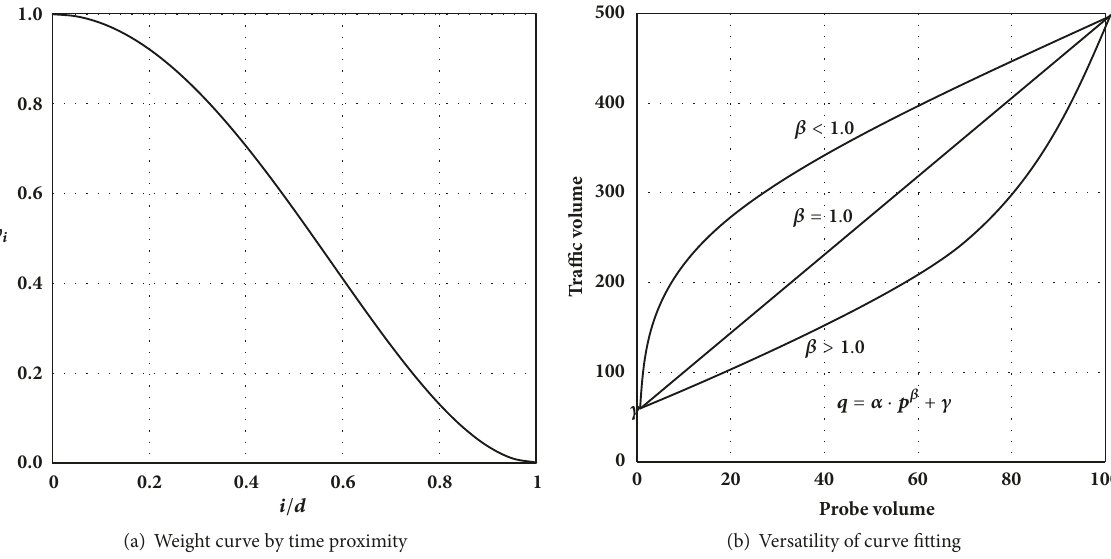
Figure 2: Power curve for expansion of probe